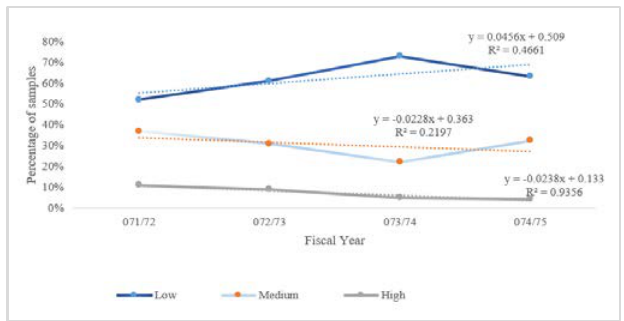
Figure 1: Status of soil organic matter in FY 2070/71 (2013/14) (Source: Dawadi & Thapa [19]) Based on the soil samples analysed by soil laboratory located at soil management directorate and regional soil laboratories located at various locations, it was found that soil samples with low soil organic matter declined by 0.04 units per year from fiscal year 071/72 to 074/75. Moreover, there was decline in soil samples with medium and high organic matters by 0.0228 and 0.0238 units per year during the same period (figure 2).